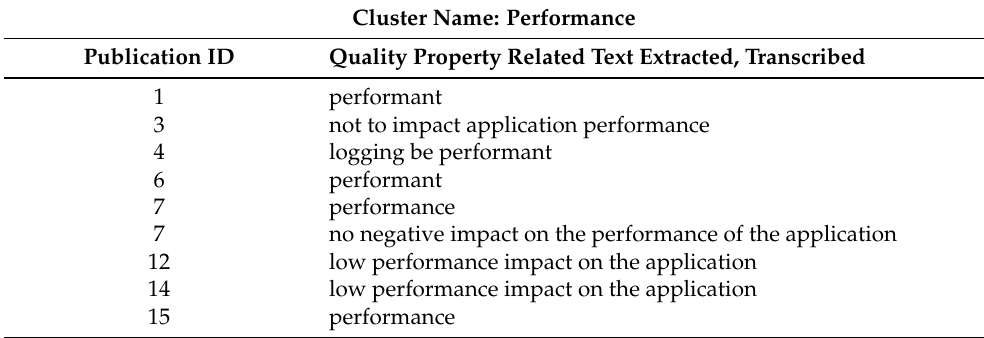
Table A7. Quality Property Cluster: Performance.